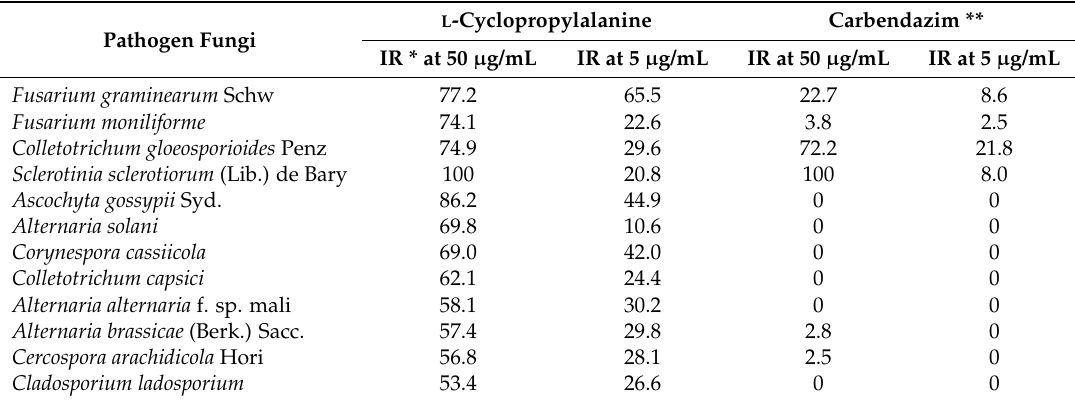
Table 1. Inhibitory effects of L -cyclopropylalanine on 12 plant pathogen fungi in PDA plates. L -Cyclopropylalanine Carbendazim Pathogen Fungi